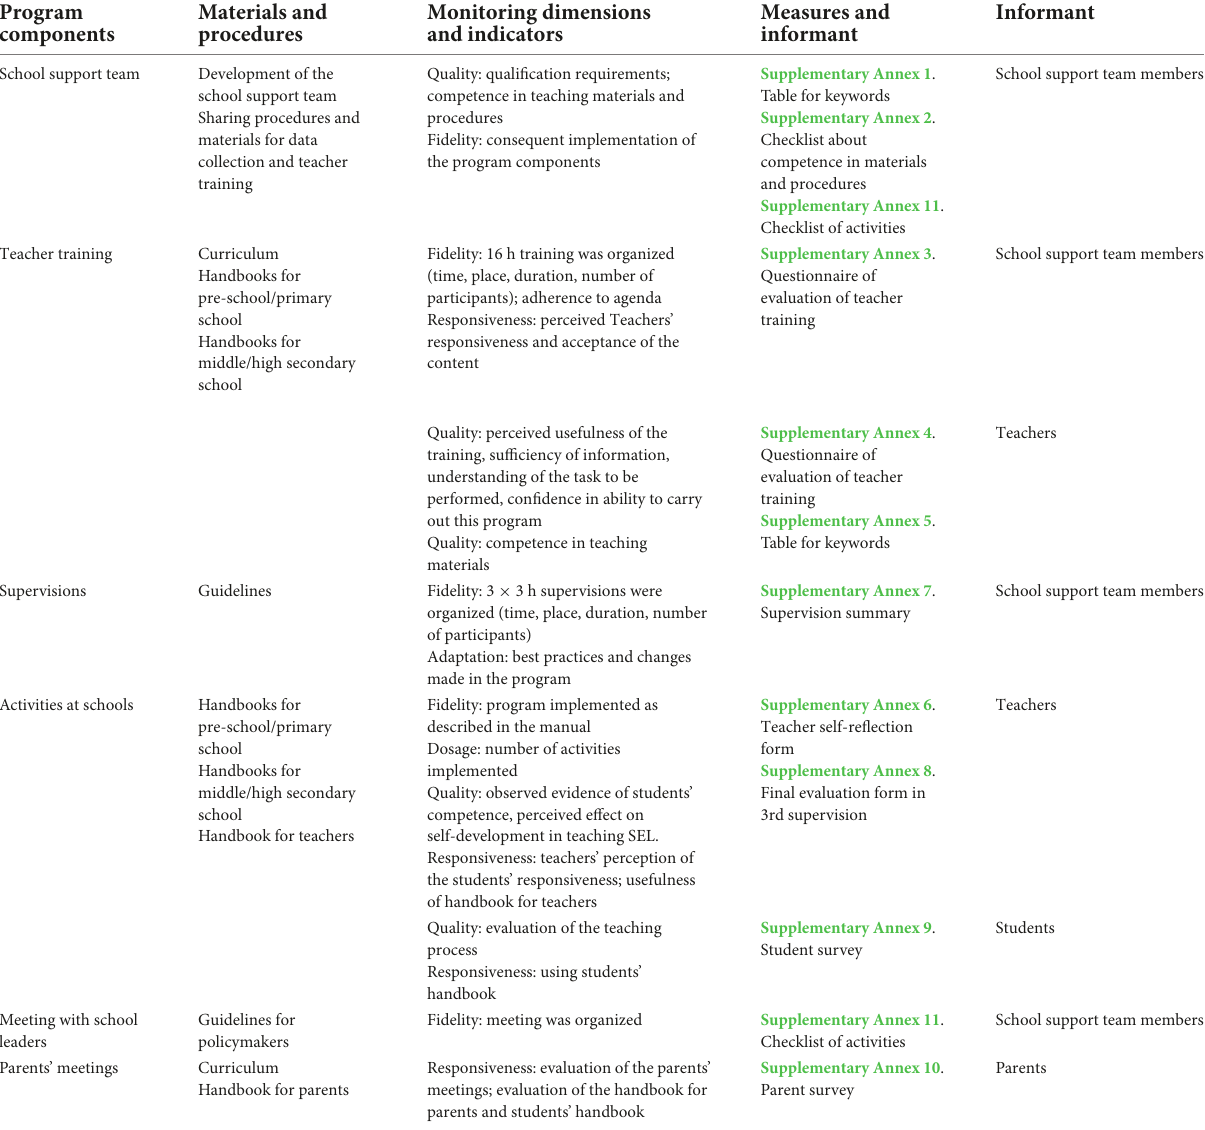
TABLE 2 Monitoring system for evaluating the implementation of Promoting Mental Health at Schools